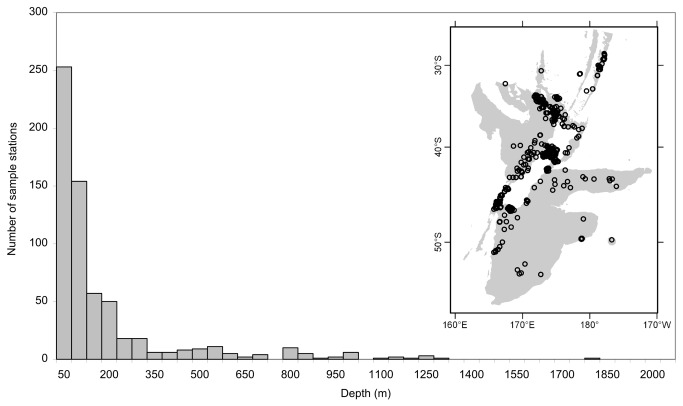
Summary distribution of collated bryozoan records.Frequency of target-group background sampling (including presence points) in 50 m depth classes. The insert shows the geographic distribution of these sites, with gray shading showing water depths <2000 m, beyond which samples were excluded.